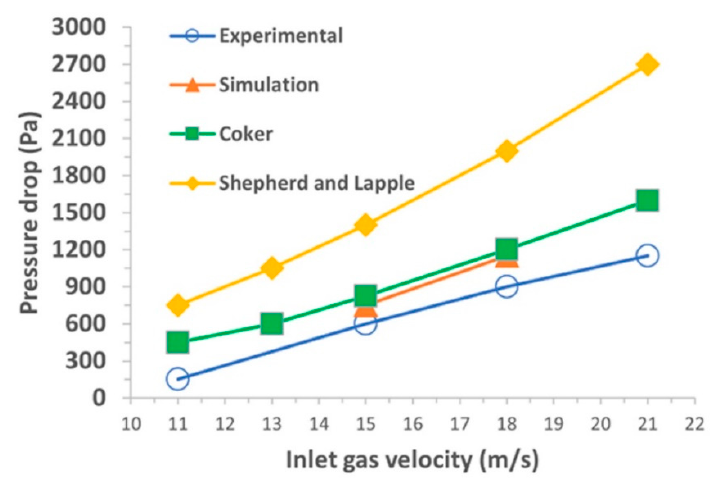
Figure 9. Comparisons of pressure drops.